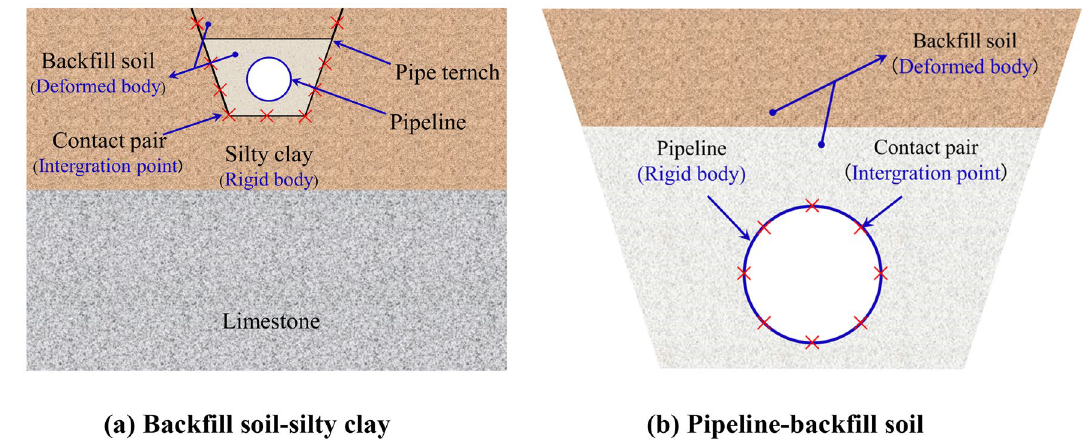
Figure 5. Schematic diagram of the interaction contact